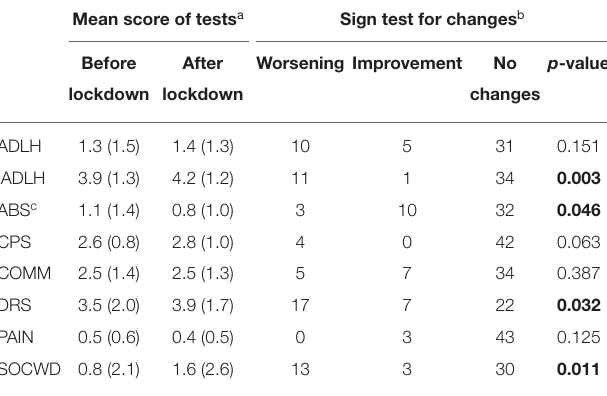
TABLE 2 | Mean scores of the scales before and after the lockdown and sign test for the evaluation of changes in participants condition during the lockdown. Mean score of tests a